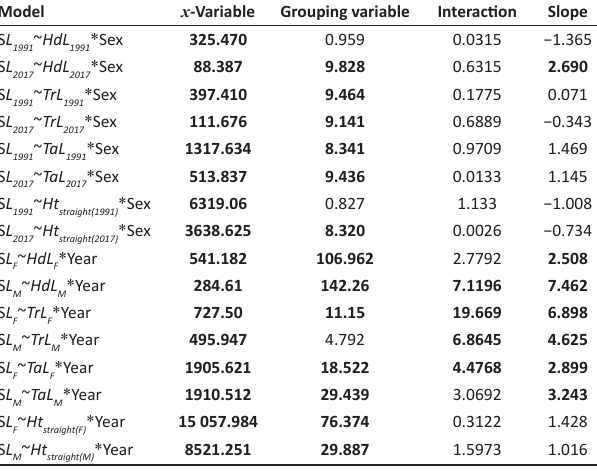
TABLE 3: Test statistics of regression models of standard length with head length , curved trunk length and curved tail length, showing interaction between the measured variables and sexes and years, respectively.